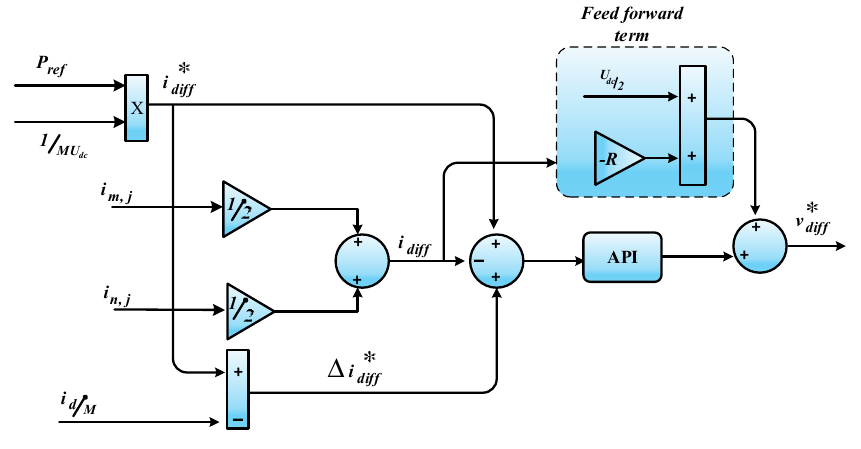
Figure 8. Circulating current control.